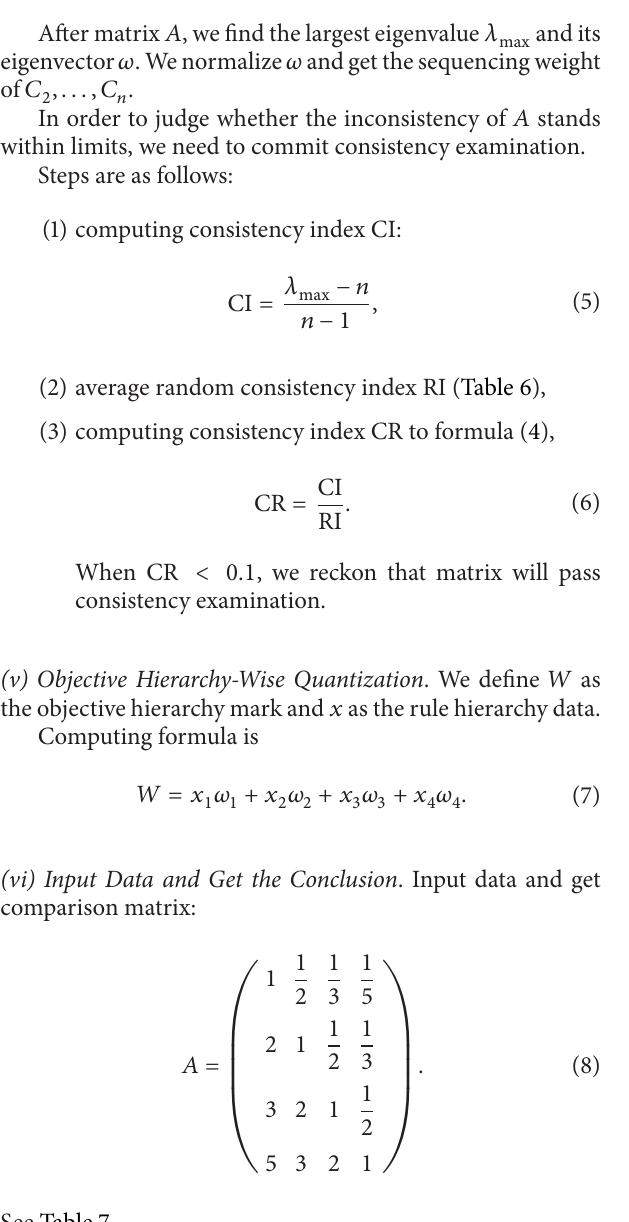
Table 5: Priority order evaluating different games. Award Importance level CREG 𝐶 NCAA 𝐶 FF 𝐶 NC 𝐶